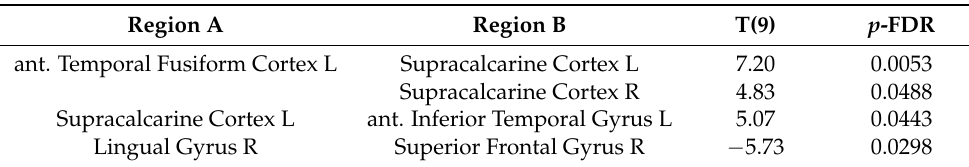
Table 2. Functional connectivity changes following Fr-PCA therapy.